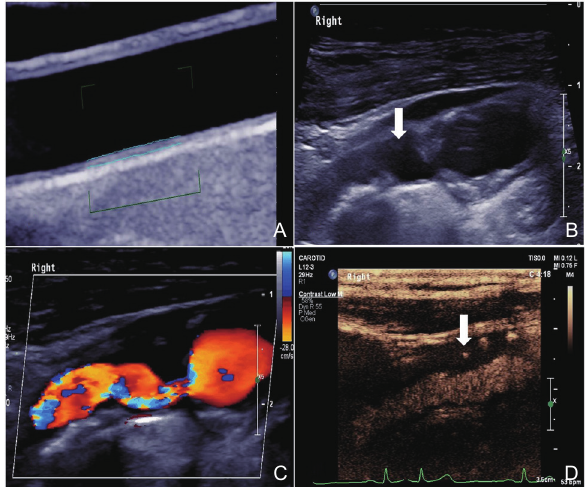
Figure 3 Ultrasonography exam for the carotid artery. (A) Intima-media thickness measurement; (B) By B-mode ultrasound, plaque ulceration was shown at the origin of the right carotid artery; (C) A severe stenosis due to atherosclerosis plaque was shown in the color mode ultrasound; (D) Neurovascular was detected by contrast-enhanced